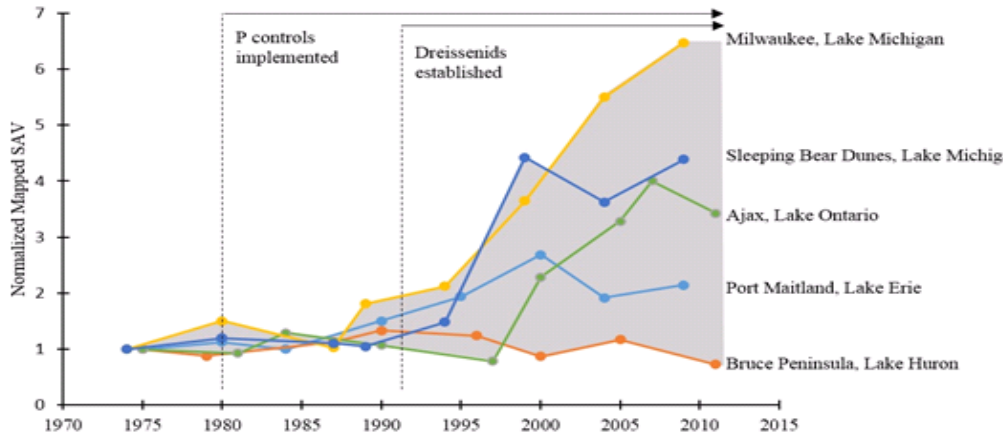
Figure 6: Mapped SAV area for five focus areas within the lower four Great Lakes. Each focus area is normalized to the initial SAV area to compare growth between focus areas.